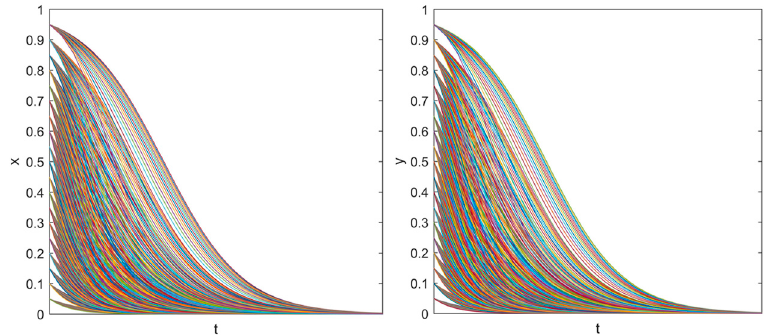
Figure 13. Strategies’ evolutions of the grid company and user over time in Case 4.